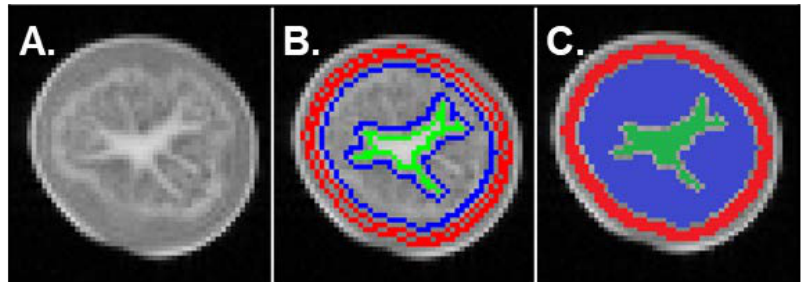
Figure 4. ( A ) MRI image acquired with a Multi-Spin Echo sequence (echo time = 130 ms, repetition time = 10 s, 0.8 × 0.8 × 5 mm 3 voxel) of a potato tuber at 60 days after shoot emergence (DASE). ( B ) Masks of the three different tissues (cortex, flesh, pith) obtained by means of an automatic segmentation algorithm developed for transverse relaxation time (T 2 ) computation. ( C ) The three different regions obtained following segmentation according to T 2 : cortex (red), flesh (blue) and pith (green). See Supplementary Figure S1 for images of the other tubers analyzed at 60 DASE. Table 4. Statistical evaluation of the effect of tissue type on MRI parameters (ANOVA test